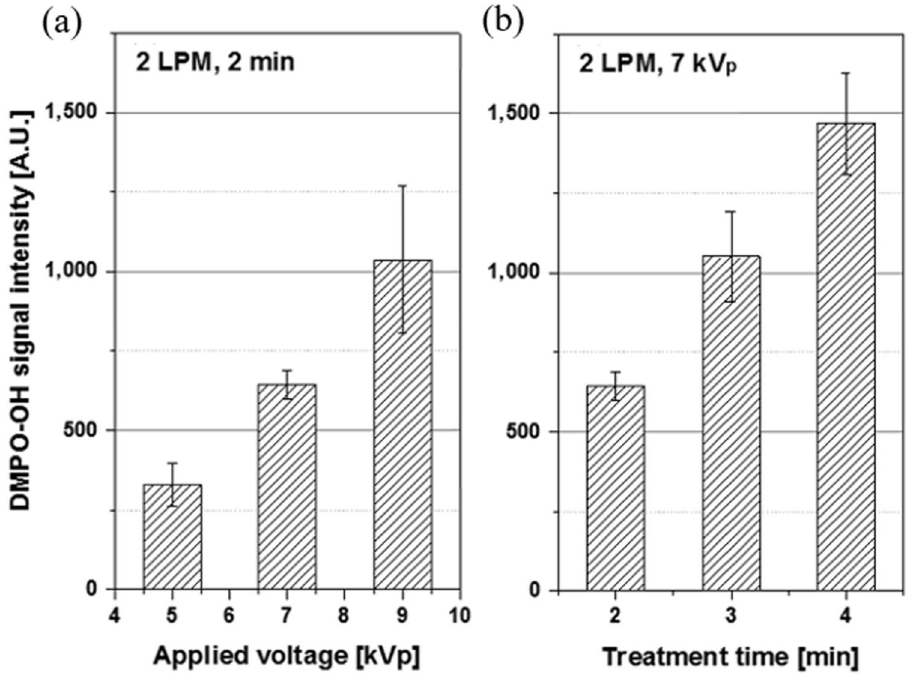
Figure 3. DMPO-OH signal intensities in an arbitrary unit: ( a ) from 2 min plasma treatments at the helium flow rate of 2 LPM with the applied voltage at 5, 7, and 9 kVp and (b ) from 2, 3, and 4 min treatments at 2 LPM and 7 kVp. Each error bar indicates one standard error of the mean obtained from three independent